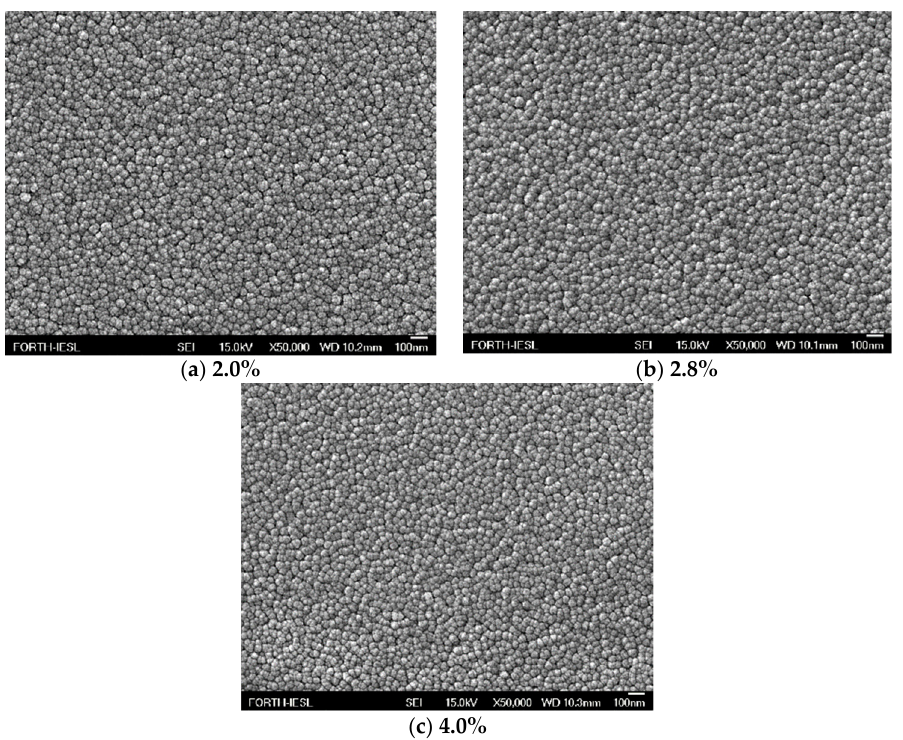
Figure 3. SEM images of rf-sputtered NiO:Al films grown at room temperature with ( a ) 2.0%, ( b ) 2.8%, and ( c ) 4.0% O 2 content in plasma that underwent thermal annealing at 400 °C for 24 h. The transmittance spectra of the Al-doped NiO films are shown in Figure 4. All films were highly transparent (>70%) in the visible region as well as in the near infrared one. Using Equation (3) and the Tauc plot (inset of Figure 4), the optical energy bandgap was calculated and found to be around 3.66 eV (Table 1), comparable with the values reported by Chattopadhyay et al. for Al-doped NiO films grown by the rf sputtering technique [25].